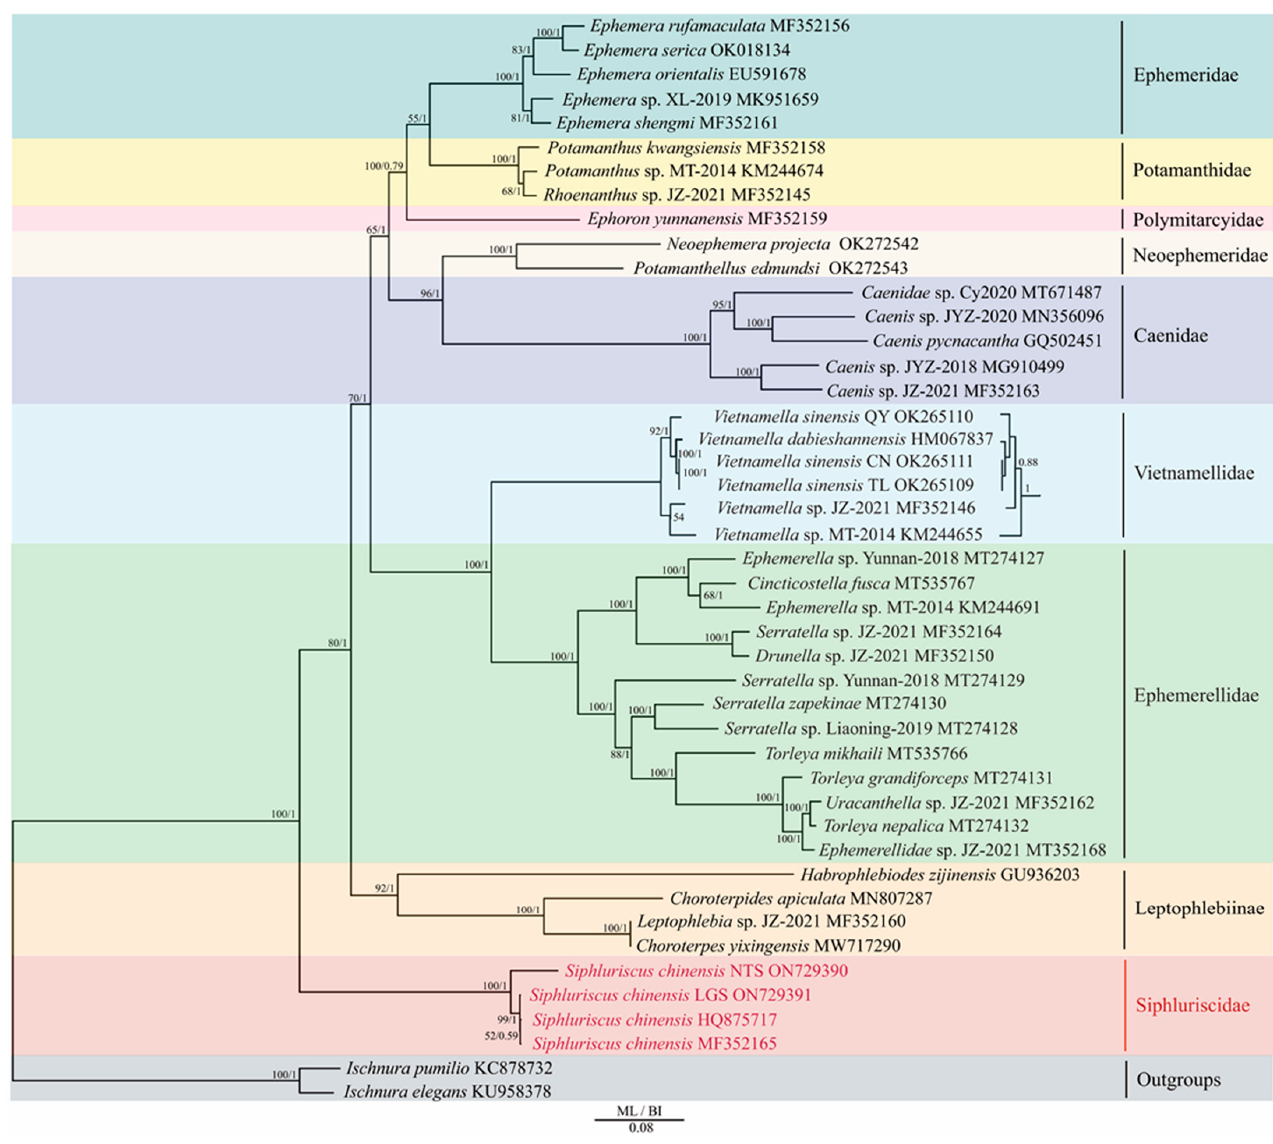
Figure 5. The ML ( left ) and BI ( right ) phylogenetic relationships among 45 species are based on the nucleotide dataset of the 13 mt PCGs. Ischnura pumilio (KC878732) and Ischnura elegans (KU958378) were used as the outgroups. The number on the left around each branch illustrates the bootstrap percentages of ML, whereas the number on the right indicates the posterior probability of BI. To the right of each species name is the GenBank accession number. The name of each Ephemeroptera family is listed on the right side of the figure and is distinguished by different colors. Species within Siphluriscidae are highlighted in red font. Table 3. Divergence times of nodes and clades within Ephemeroptera based on the mt genomes. All estimates are expressed as million years ago (Mya). The 95% highest posterior densities (HPD) are shown in the right column of the table. “&” represents the relationship between two